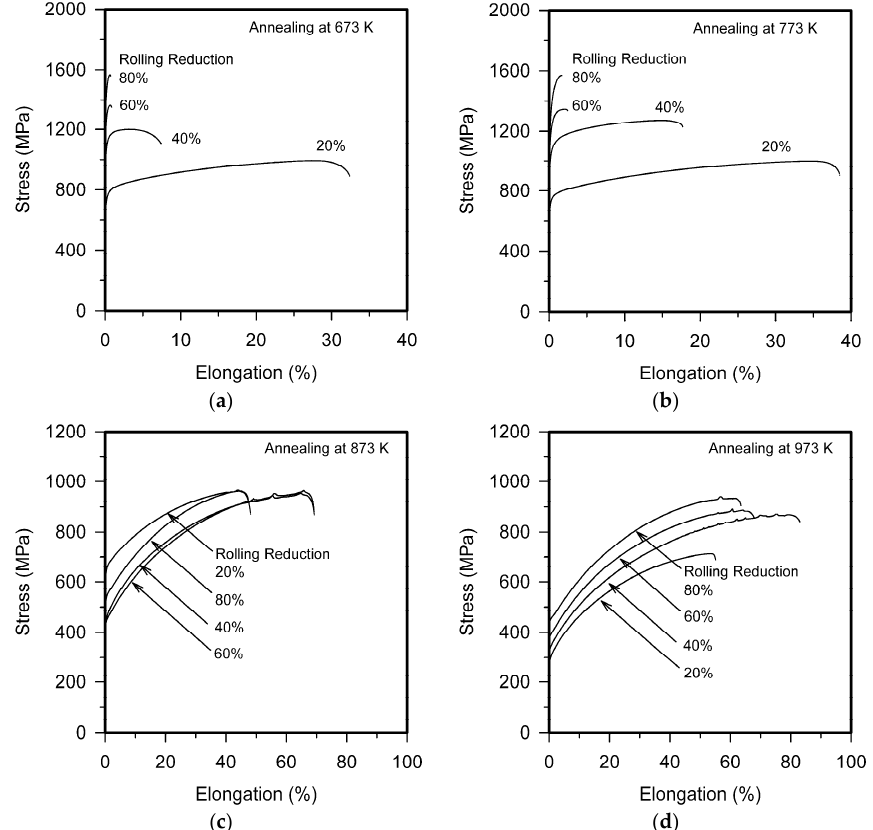
Figure 7. Engineering stress vs. elongation curves for a high-Mn steel subjected to cold rolling followed by annealing at ( a ) 673 K; ( b ) 773 K; ( c ) 873 K; ( d ) 973 K.